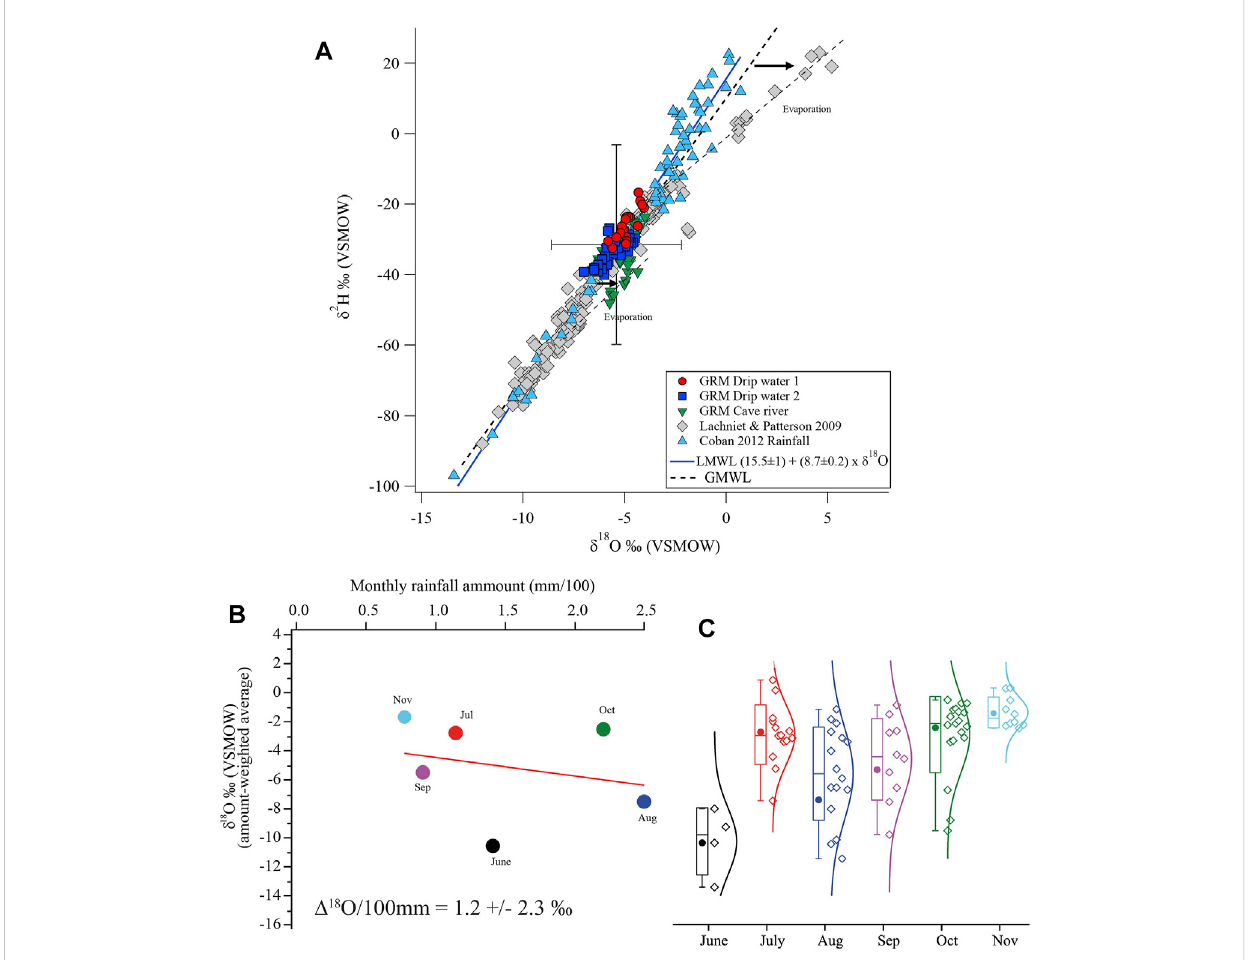
FIGURE 3 Isotopic composition of summer rainfall for 2012 from Cobán, Alta Verapaz, GT. (A) δ 2 H vs. δ 18 O for 2012 June – November rainwater collected at FincaMonteAzulnearCobán,AltaVerapaz,(cyan),dripwaterfromDS1(red)DS2(darkblue)andcaveriverwater(green),comparedtothecompositionof natural waters from Guatemala (Lachniet and Patterson, 2009). Error bars correspond to the amount-weighted δ 18 O and δ 2 H for the rainfall samples collected. GlobalMeteoricWaterLine (continuousblue)and theLocalMeteoricWater Line (dashed black) arealso presented. (B) amount-weighted monthly average δ 18 O vs. monthly rainfall amount (mm/100), red-line corresponds to the linear regression, with the slope ( Δ 18 O/100 m), (C) whisker plot (solid: amount-weighted δ 18 O average, line = average, box: +/ − 1SD, whisker = Max and min) showing the progression of the 2012 rainfall δ 18 O composition from June to November. Colors in B and C correspond to different months. Reader is referred to electronic version of the